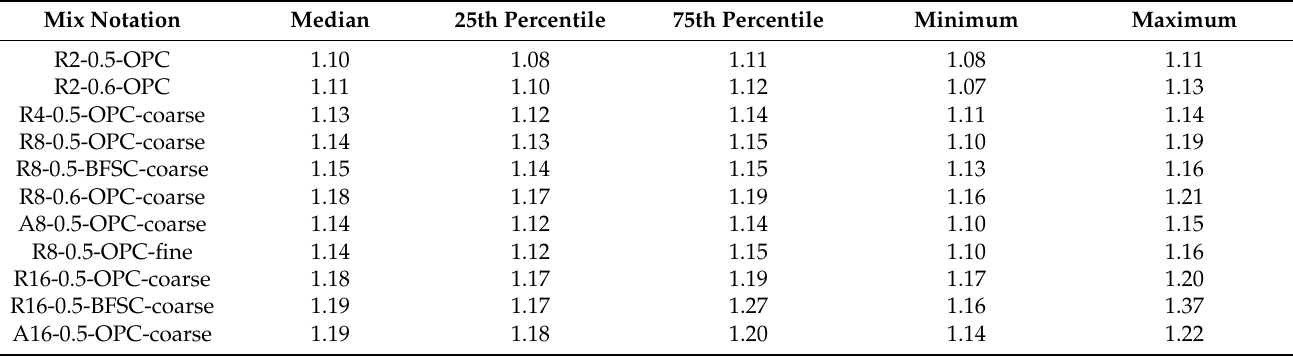
Table 2. Tortuosity τ in flow-direction